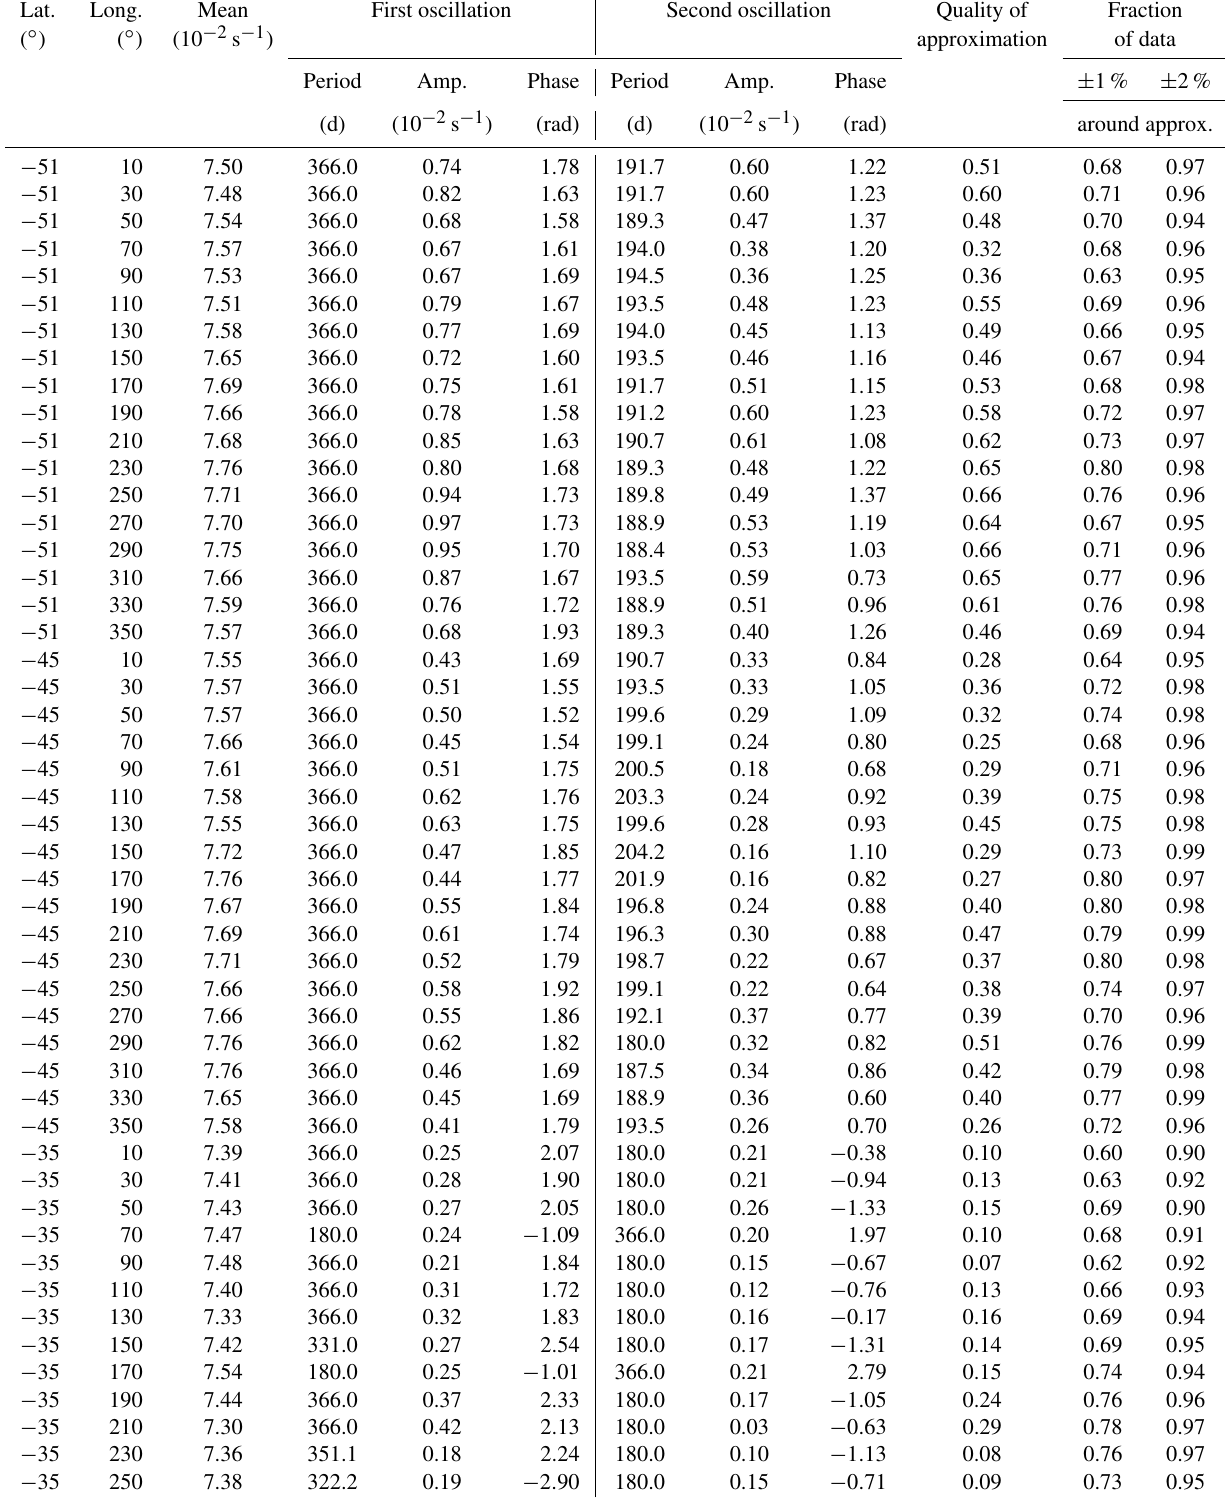
Table A2. Same as Table 1 but for the FWHM. Please note that FWHM is more variable during the year, and therefore the fraction of data around the approximation is provided for intervals of ± 7 . 5% and ± 15%.